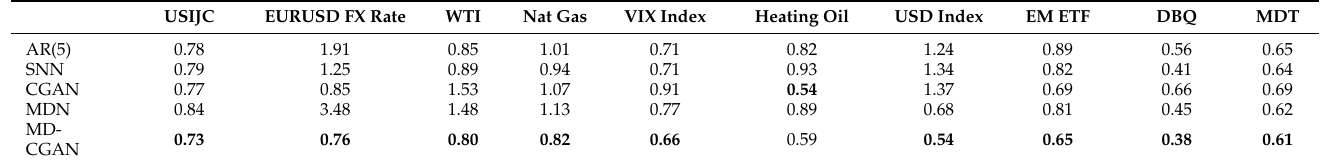
Table 3. Ratio of model MSE to martingale, AR(0), baseline model over 10-week forecast horizon.